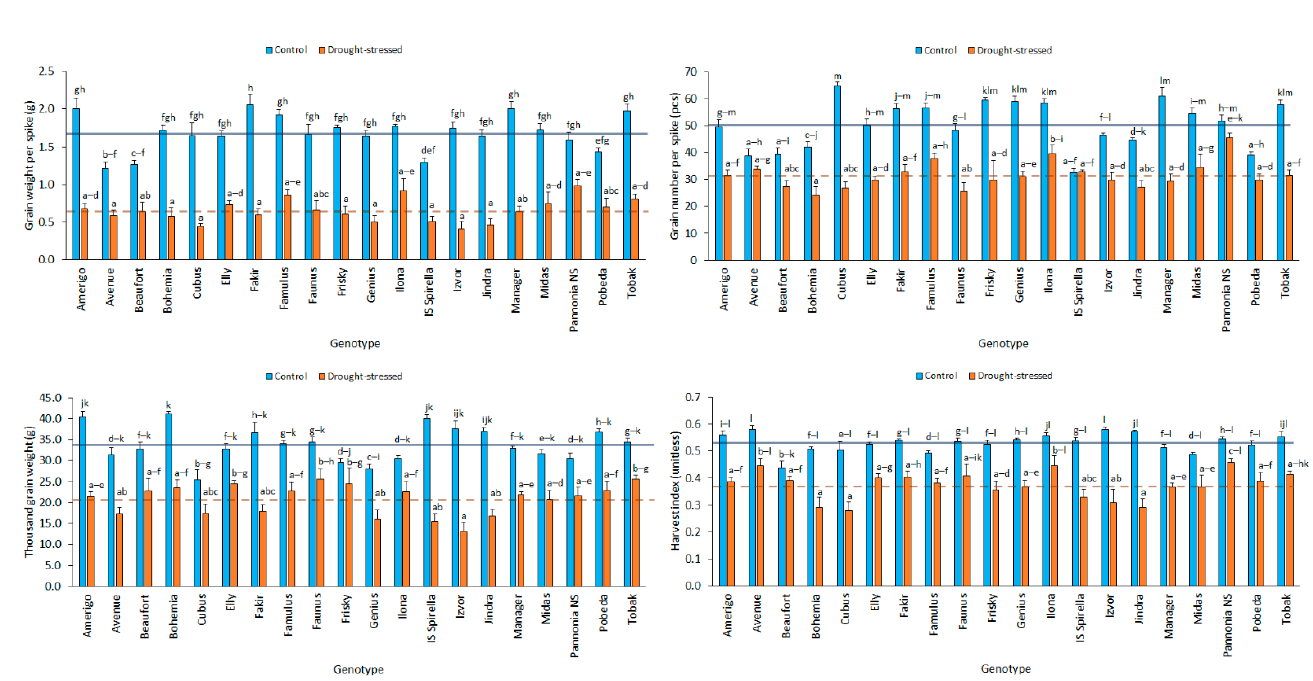
Figure 2. Mean values of GWS (g), GNS (pcs), TGW (g), and the HI (unitless) for each genotype, with standard errors of the means displayed as error bars. Two-way ANOVAs with Tukey’s post hoc tests were performed for all tested winter wheat genotypes for each yield formation parameter separately under control and drought stress treatments ( α = 0.05, n ≥ 4). Different letters above error bars denote statistically significant differences among treatments using Tukey’s post hoc tests. The blue lines represent the total mean values of the control treatments, and the orange dashed lines represent the total mean values of the drought stress treatments.